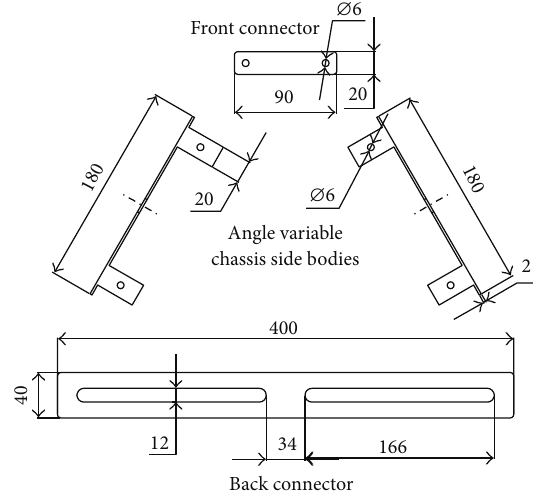
Figure 2: Angle Variable Chassis (AVC) side body and front and back connectors with dimensions (all dimensions are in mm).